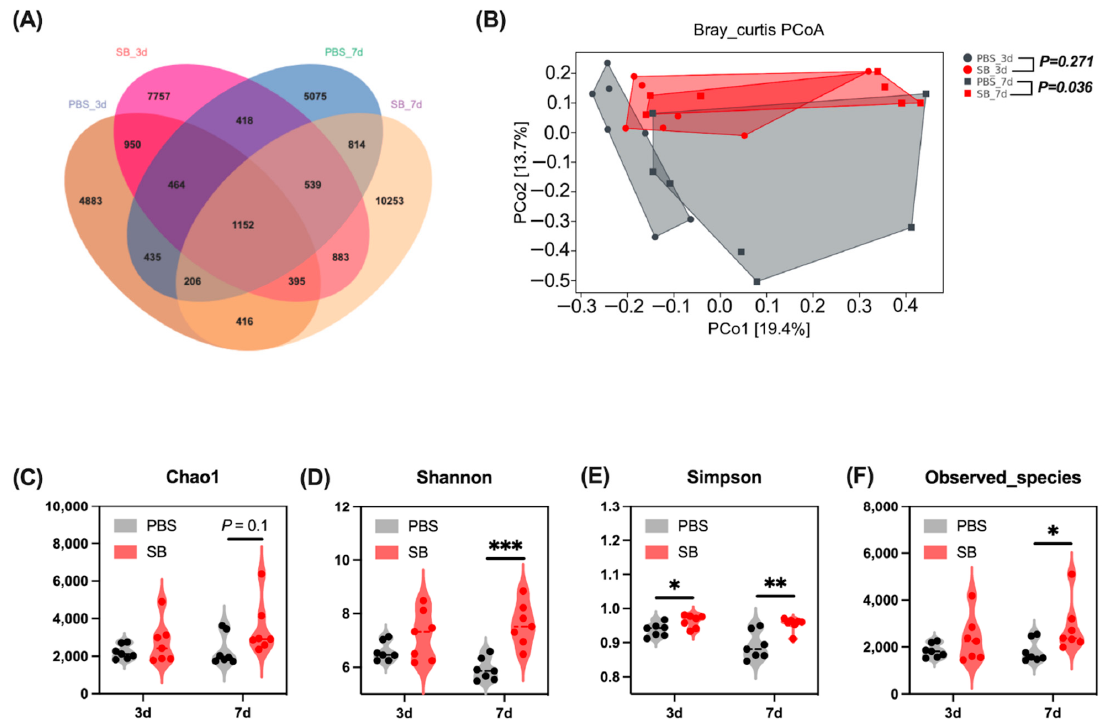
Figure 2. Effects of S. boulardii early intervention on the gut microbial diversity. ( A ) Venn diagram of core operational taxonomic units in the colonic content. ( B ) β -diversity of PCoA based on Bray– Curtis distances. α -diversity including Chao1 index ( C ), Shannon index ( D ), Simpson index ( E ), and Observed_species ( F ). Values are expressed as means ± SEM, n = 7, * p < 0.05, ** p < 0.01, *** p < 0.001. d, day. PBS, rats early intervened with phosphate buffer solution. SB, rats early intervened with S. boulardii . S. boulardii early intervention significantly changed the phenotype of the gut microbiome. The effects of S. boulardii early intervention on colonic content microbiota α and β di- versity were measured. On day 3 after weaning, S. boulardii early intervention